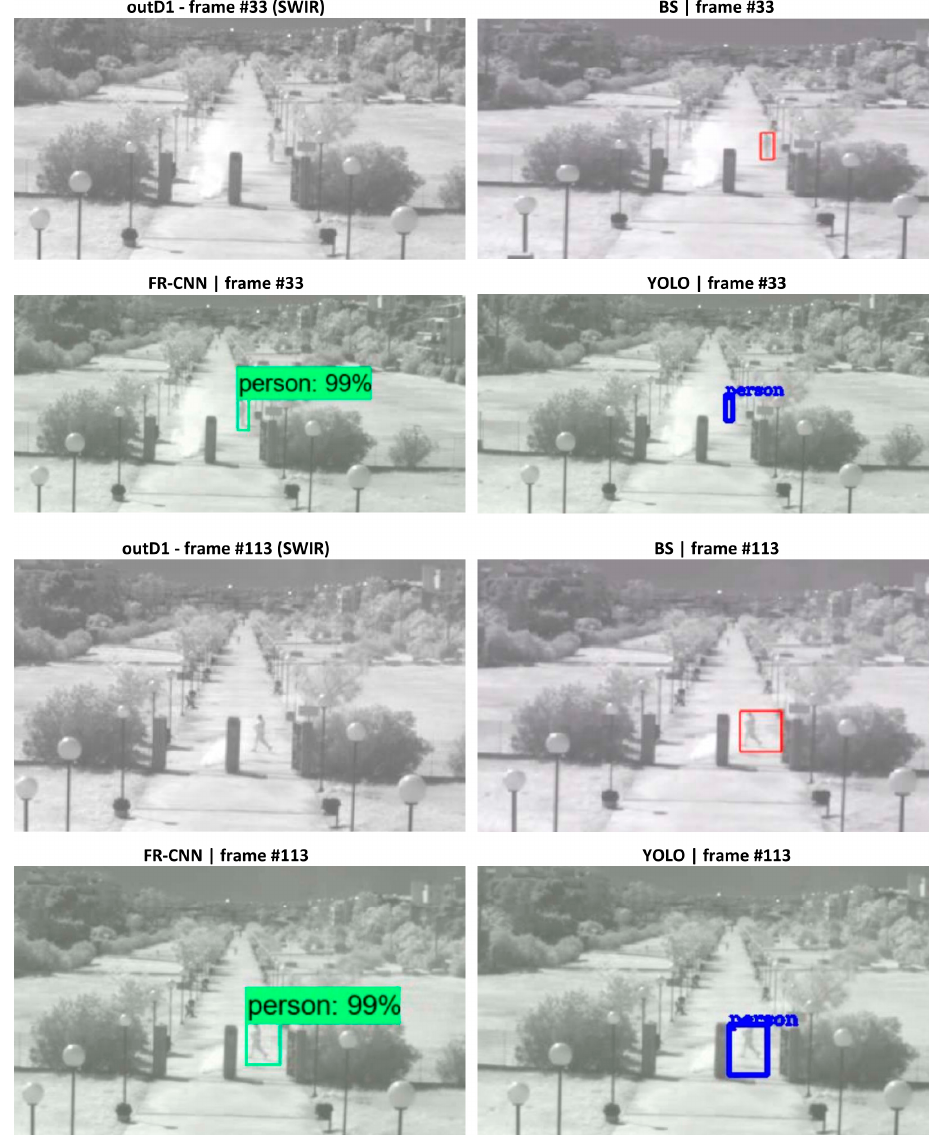
Figure 9. Indicative successful real-time detection results on the outdoor outD1 dataset from the integrated BS, FR-CNN, and YOLO detectors on the SWIR footage.